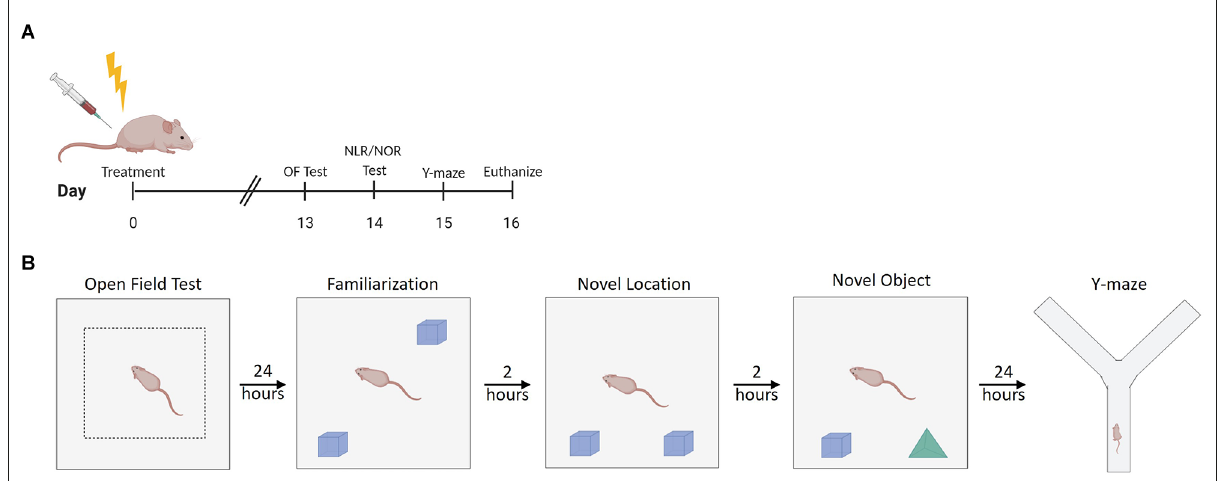
FIGURE1 Experimental design summary. (A) Experimental timeline. (B) Illustration of setup characteristics for each behavior test, including familiarization with objects prior to NLR/NOR testing. OF Test, Open Field Test; NLR, Novel Location Recognition Test; NOR, Novel Object Recognition Test; Y-maze, Spontaneous Alternation y-maze. Created with BioRender.com.